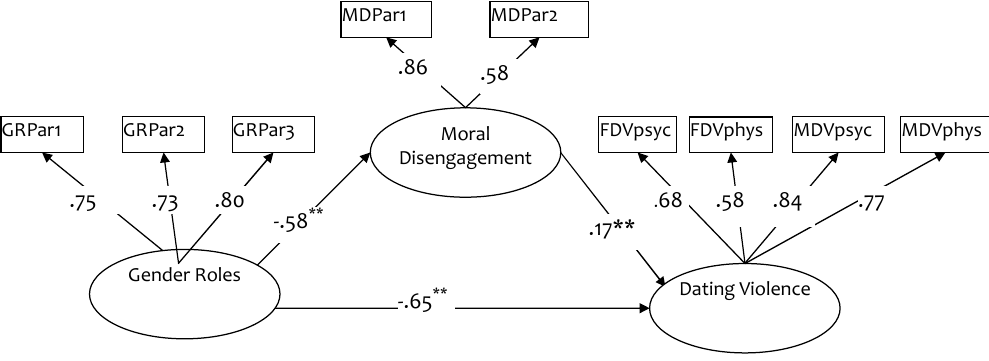
Figure 2 . Mediation for moral disengagement on dating violence via gender